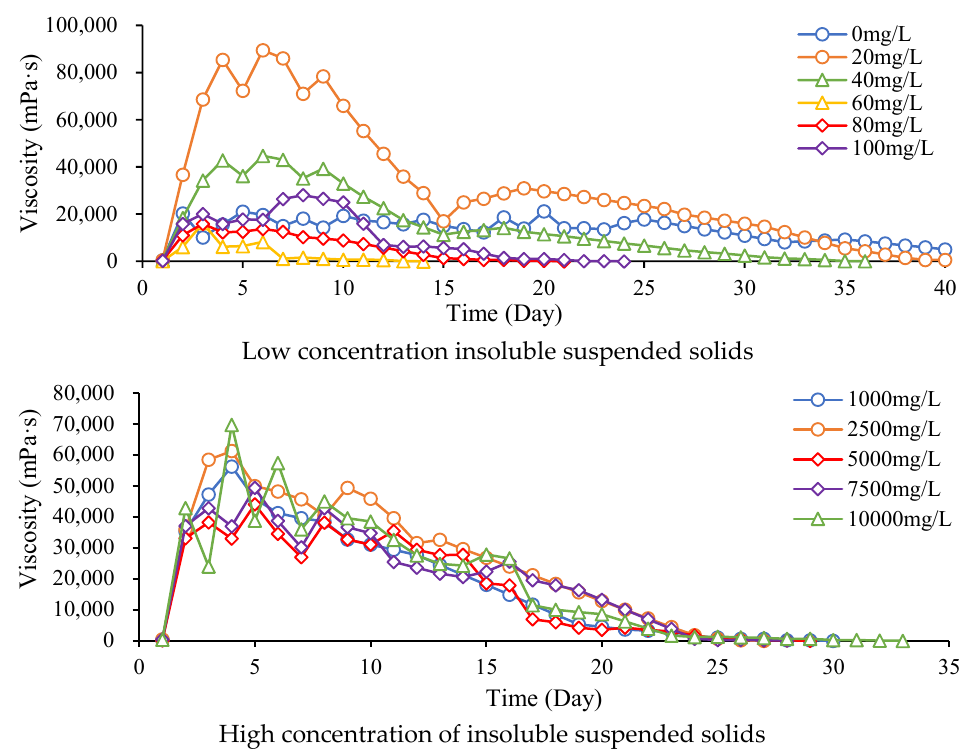
Figure 5. Influence of insoluble suspended matter on weak gel formation.